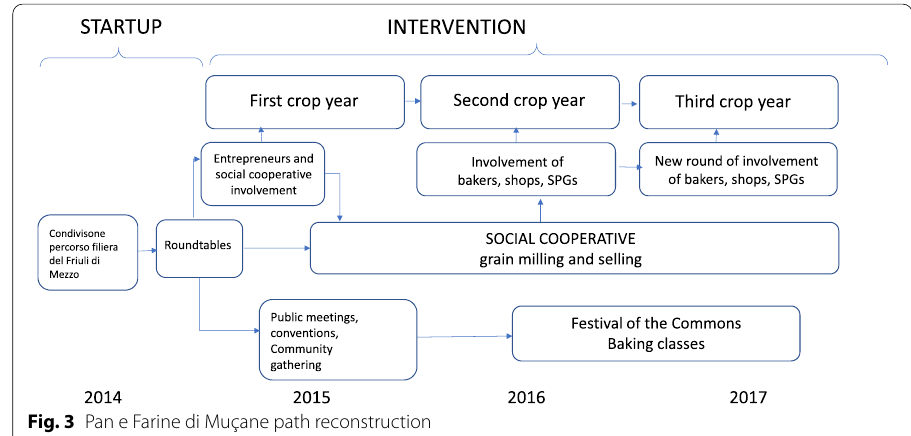
Fig. 3 Pan e Farine di Muçane path